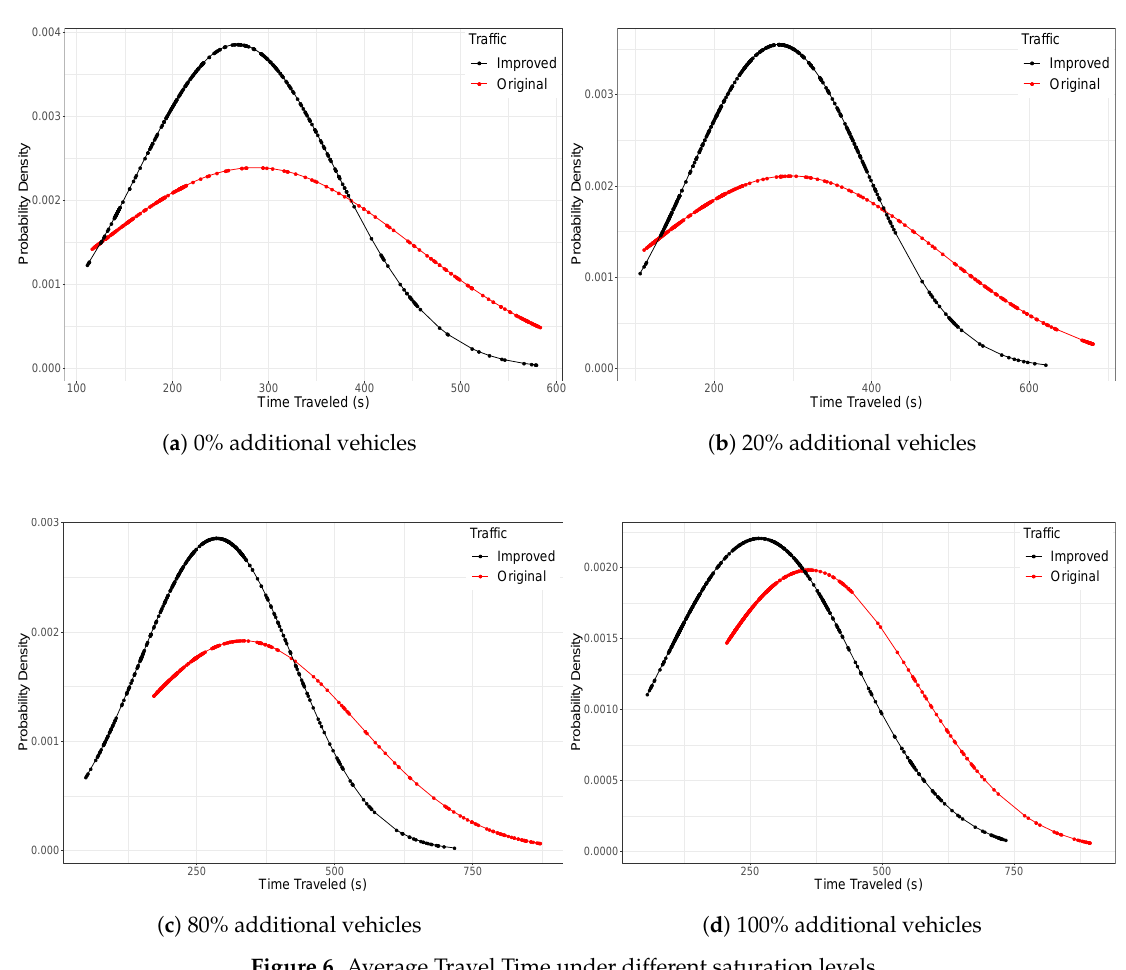
Figure 6. Average Travel Time under different saturation